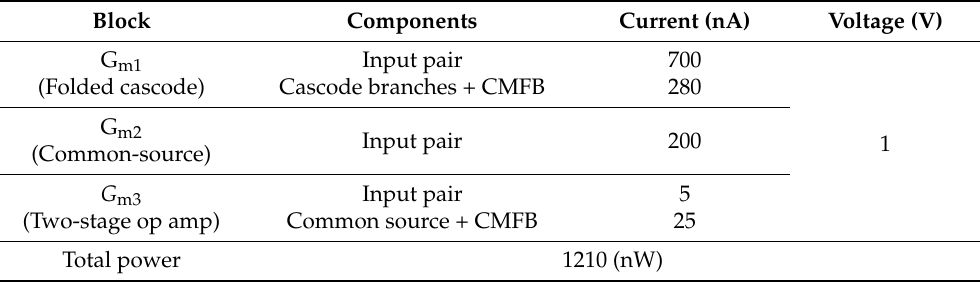
Table 2. Power Table 3. Performance summary and comparison.